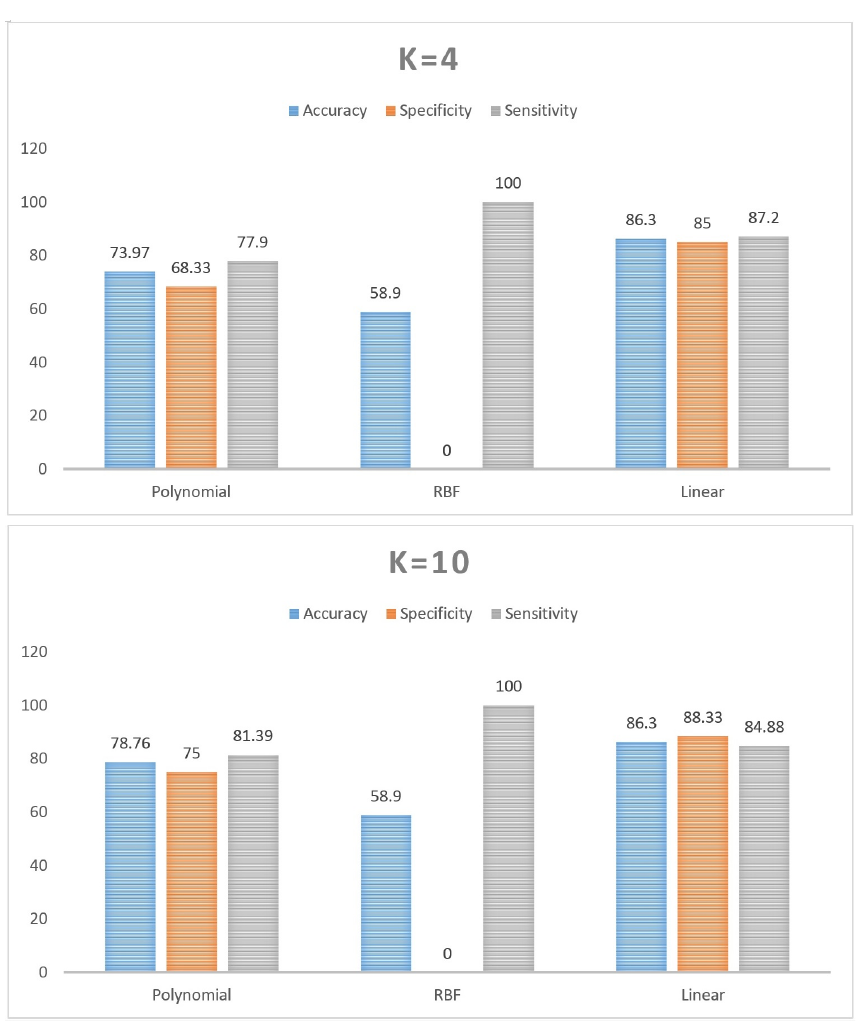
Figure 4. The results of the k-fold validation method in (%) for different SVM-based